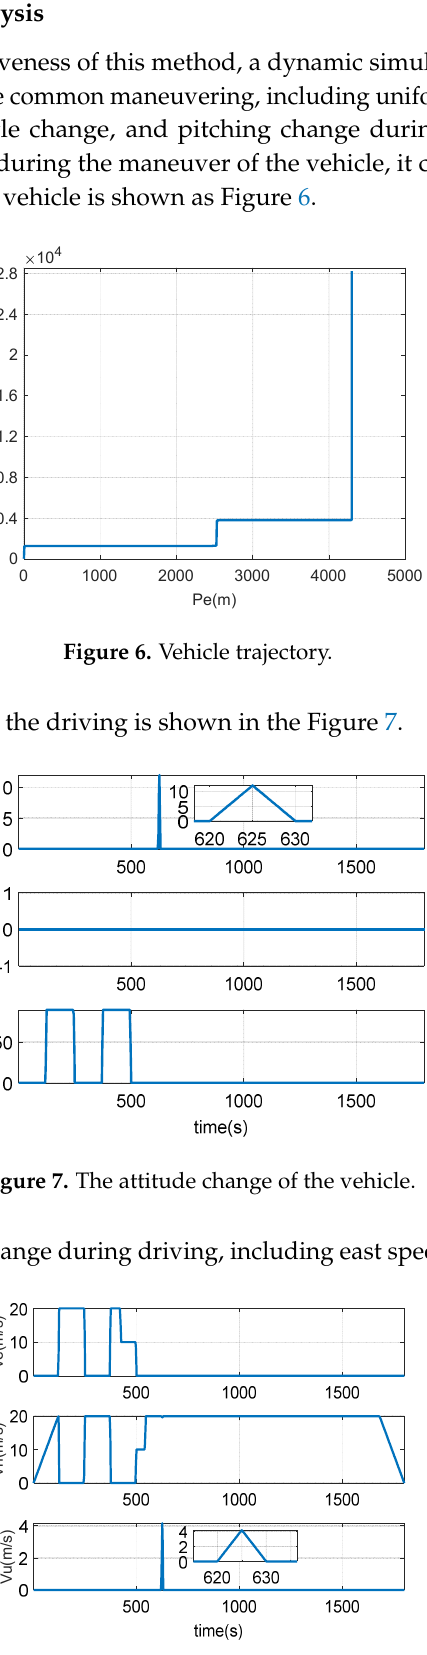
Figure 5. Observability analysis results of state variables. ( a ) Description of the   observability;  ( b ) Description of the  observability; and, ( c ) Description of the 